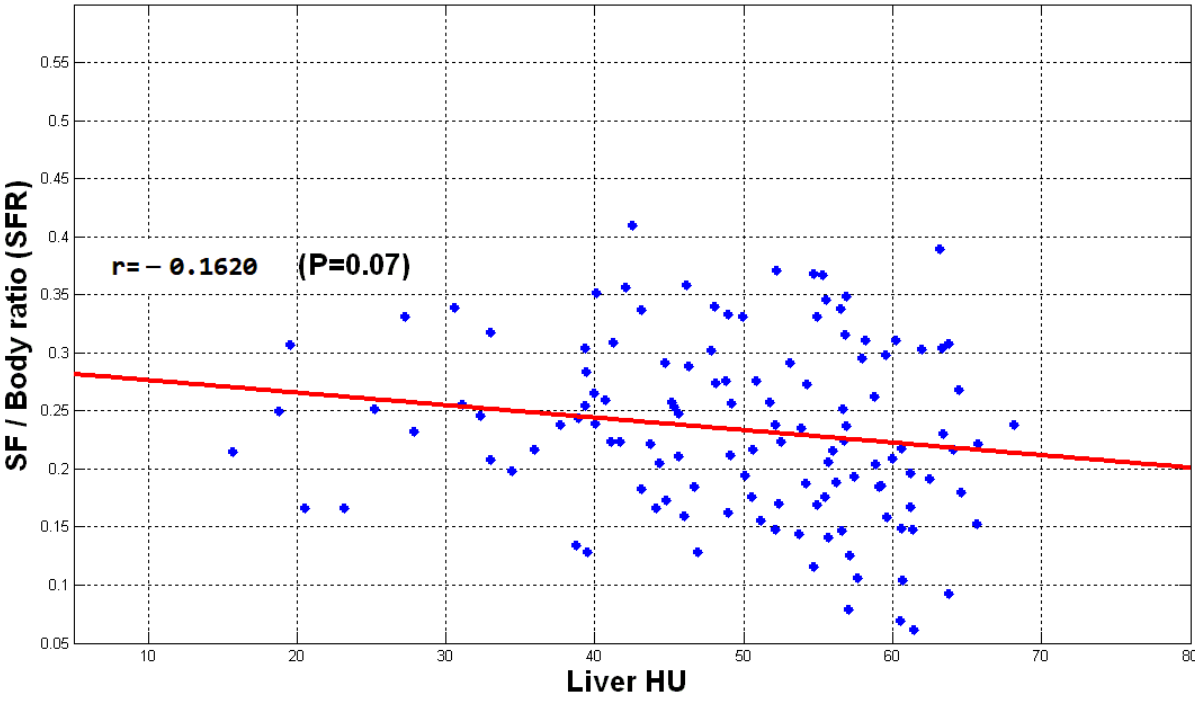
Figure 15. The plot of SFR vs. liver mean HU